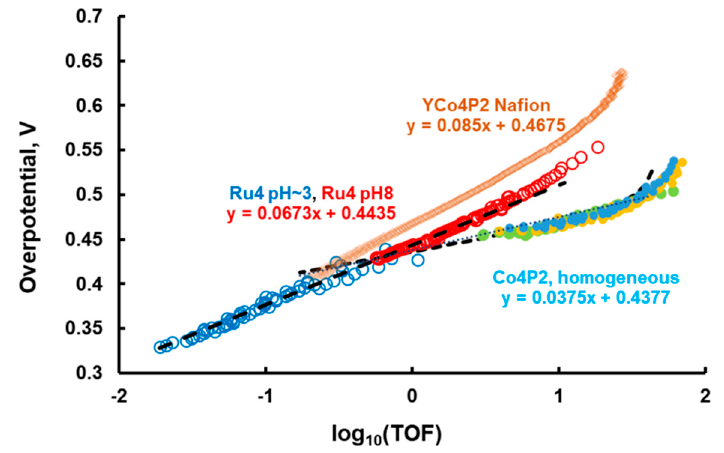
Figure 5. Tafel-like plots for water oxidation catalyzed by soluble Ru 4 POM and Co4POM (com- pletely homogeneous catalysts) derived using the described methodology compared to heterogenized POM Tafel plots measured via electrochemistry. Conditions for Co 4 POM system: 80 mM sodium borate buffer at pH 8.0, 0.34 mM Ru3, 2.5 (light blue), 5 (green), 10 (yellow) µ M Co 4 POM , 24 o C.